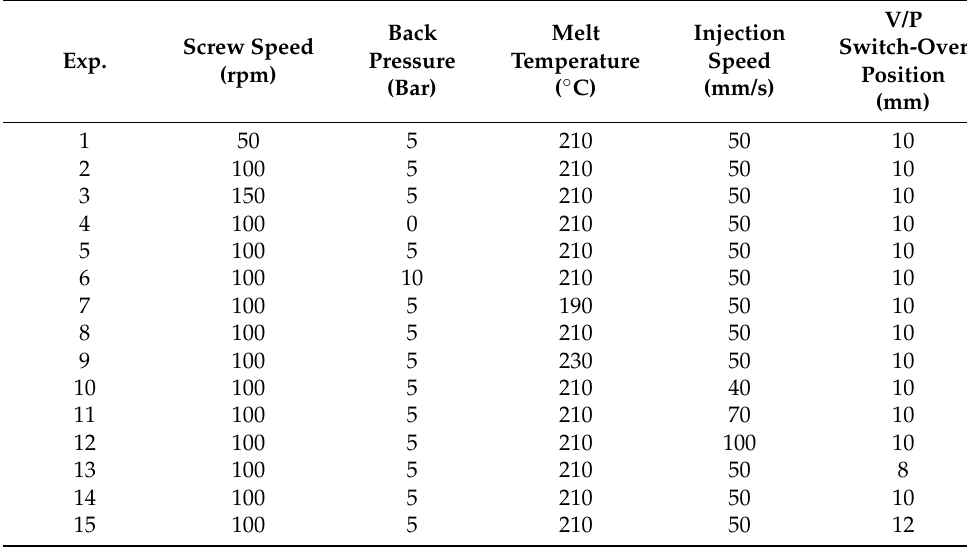
Table 2. Random order of the treatments for molding of the PP and PS samples.